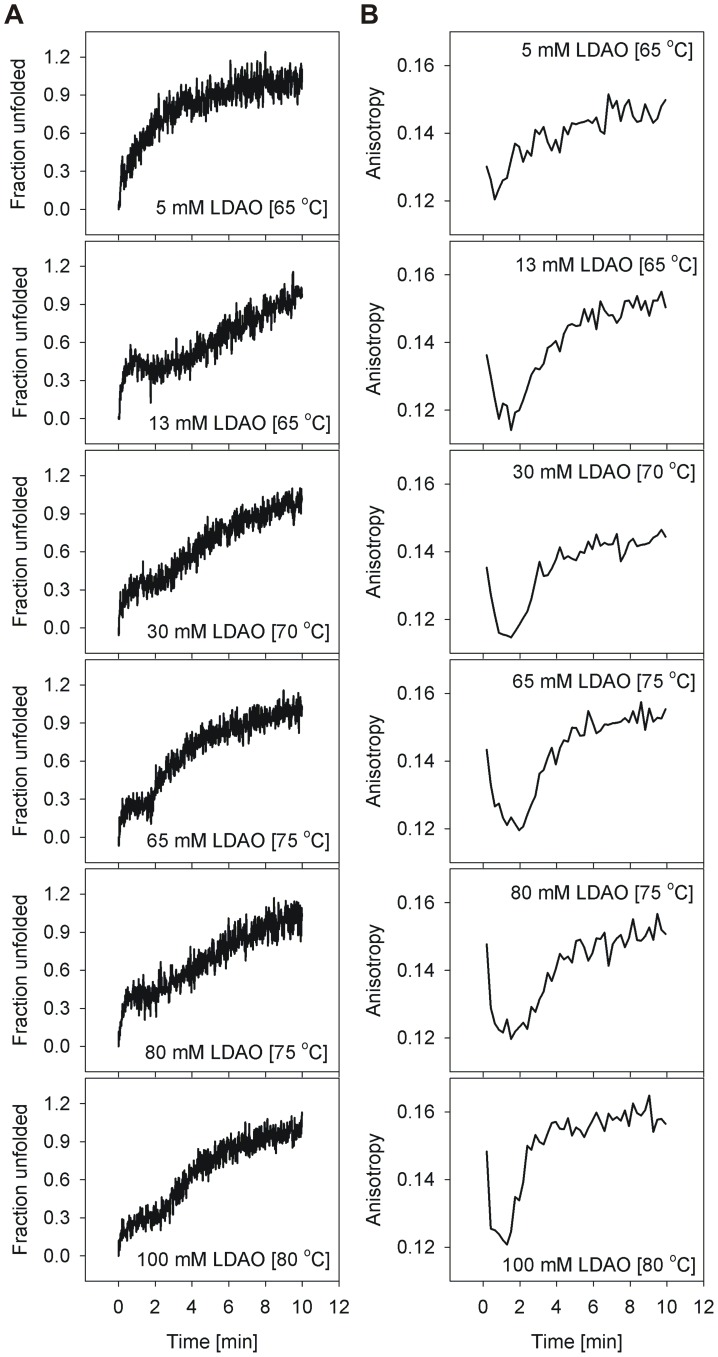
Comparison of the loss in ME215 and change in tryptophan anisotropy in isothermal unfolding kinetics of hVDAC-2 WT.Representative graphs illustrating (A) ME215 (converted to fraction unfolded) and corresponding Trp fluorescence anisotropy values (B) for all temperatures that gave rise to two transitions in the CD experiments. The change in tryptophan anisotropy was also monitored at these temperatures to understand the origin of the sequential unfolding events. The first CD transition is accompanied by a sharp decrease in the observed anisotropy, which we attribute to the initial unfolding event. ME215 recordings that showed only a single transition lack this initial decrease in anisotropy (not shown). In most of the LPRs and recording temperatures, the rise in sample anisotropy correlates well with the second transition, although the event appears to be faster in case of anisotropy measurements. This is likely to arise from the aggregation event being faster than the rate of loss of secondary structure content.